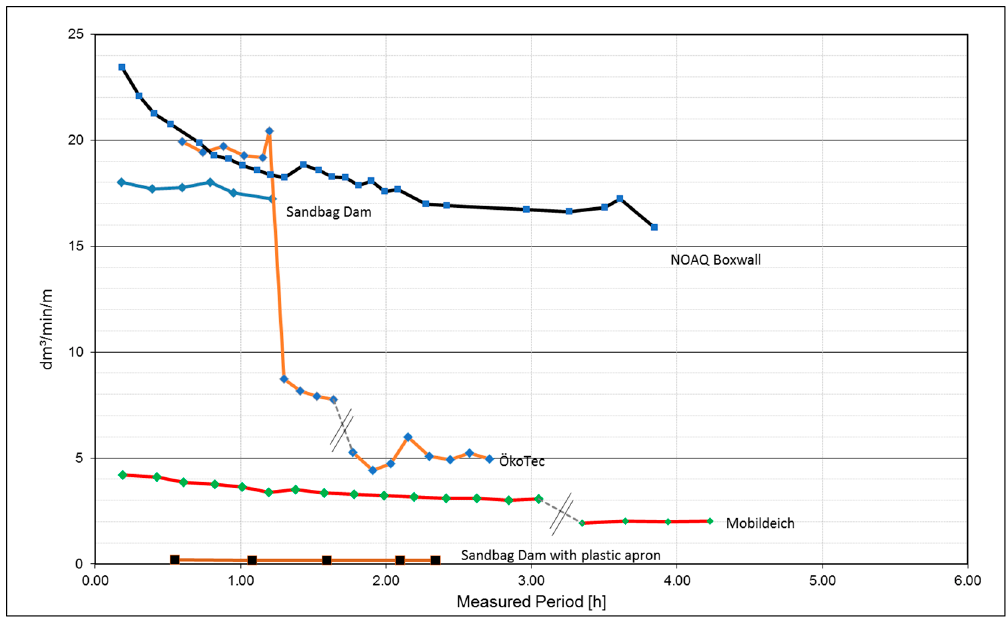
Figure 14. Selection of seepage rates of individual mobile systems with a water head of 0.6 m.